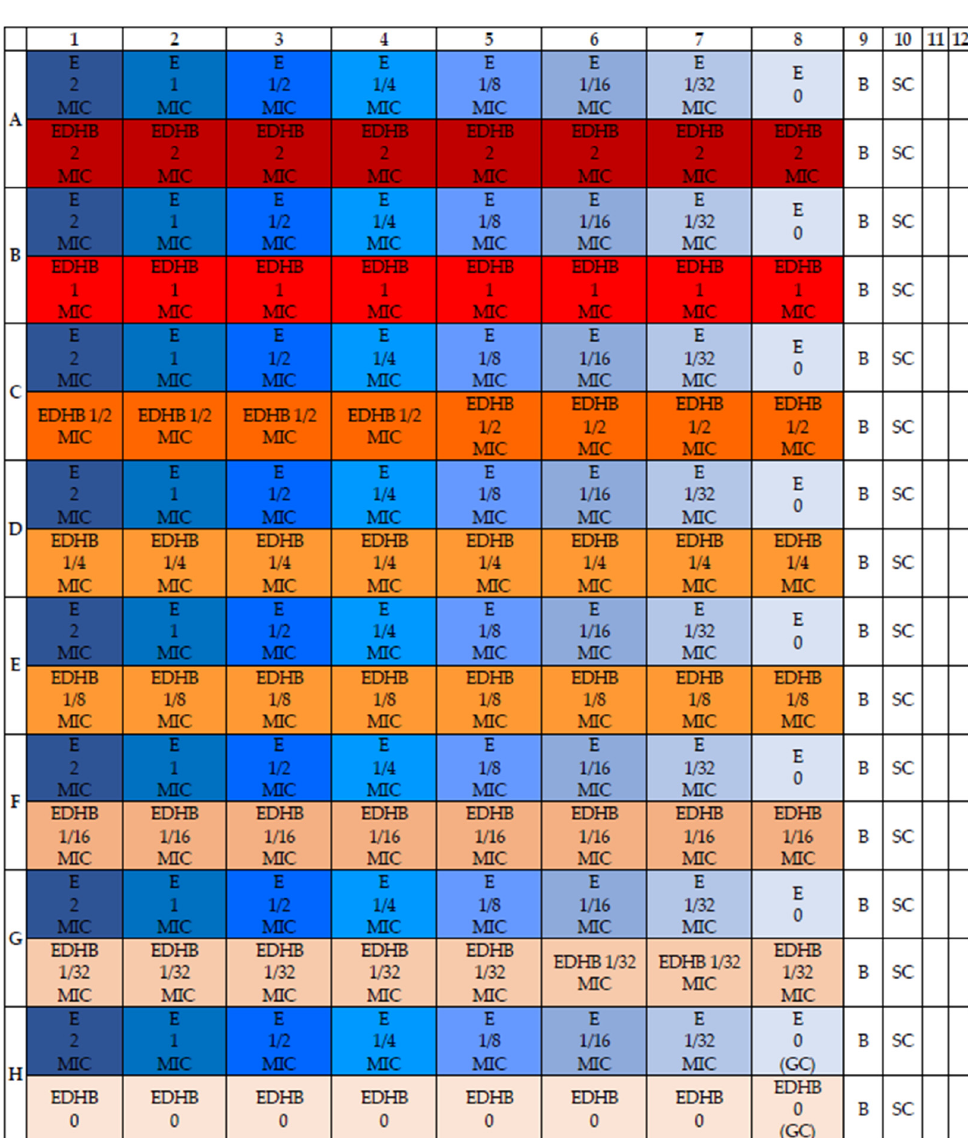
Figure 3. The scheme of the checkerboard assay to evaluate FIC index for tested strains. B—medium + solvent (background). SC—sterility control of the medium (sterility control). The first line of each row (A–H)—erythromycin (E) dilutions, the darkest color shows the lowest dilution (A1–H1), and the lightest shows the highest dilution (A8–H8). The second line of each row (A–H)—EDHB (protocatechuic acid ethyl ester) concentrations, the darkest color indicates the lowest dilution (A1–A8), while the lightest the highest (H1–H9).